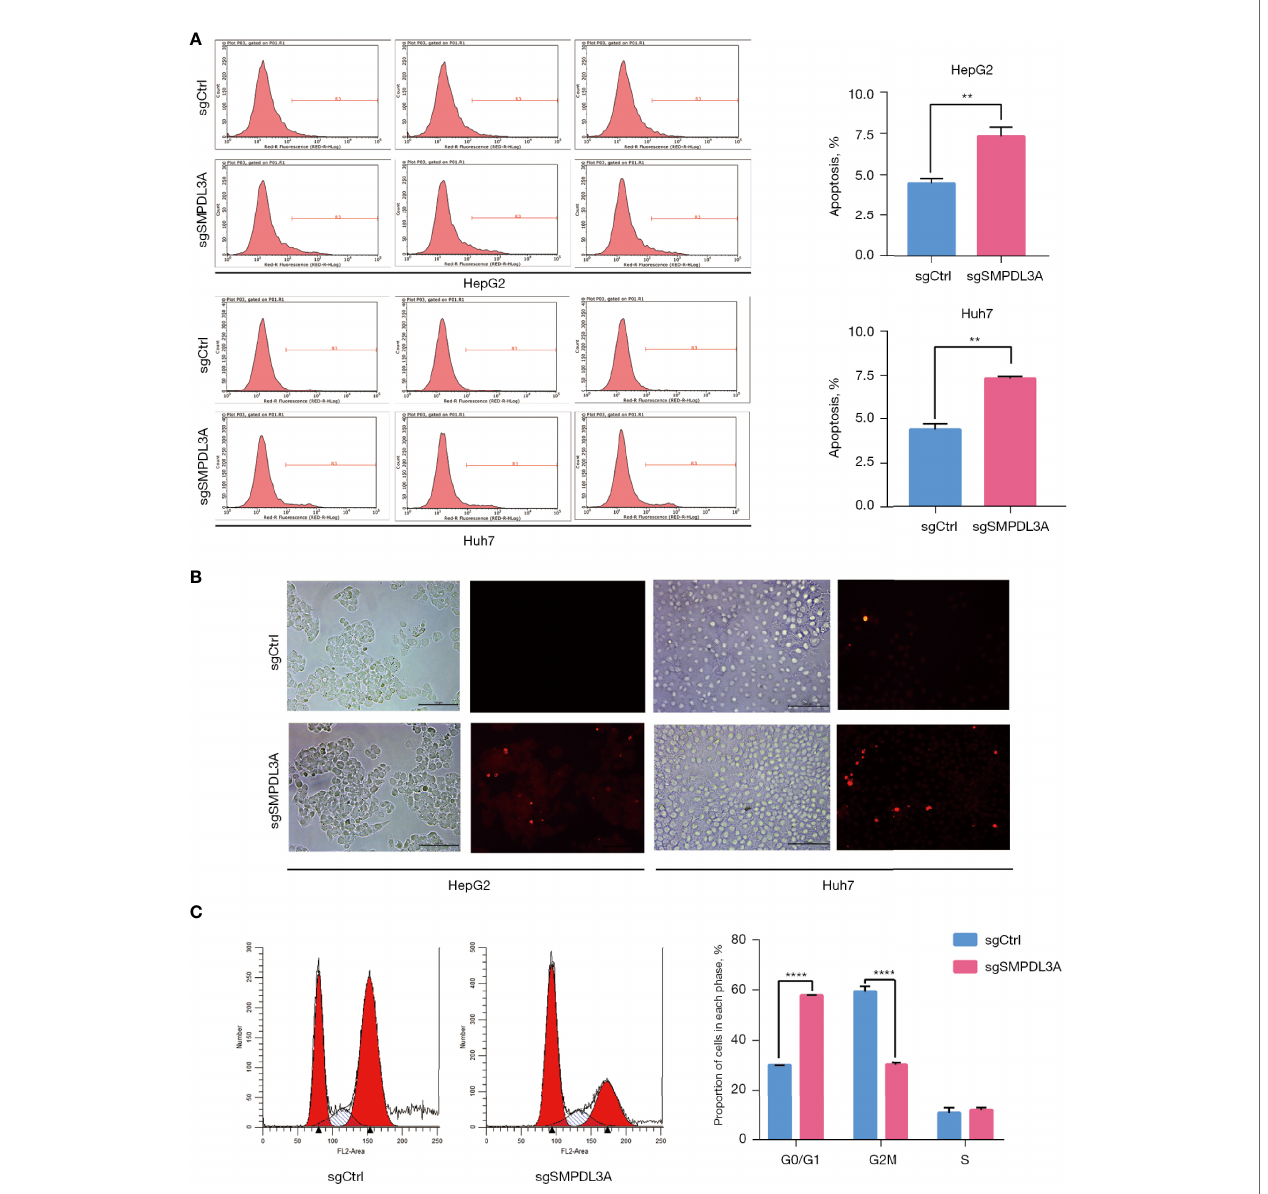
FIGURE 6 | The effect of SMPDL3A on the cycle and apoptosis. (A) Apoptotic cells were detected by fl ow cytometry (**P=0.01). (B) Fluorescence fi eld of HepG2 and Huh7 cells in the SMPDL3A knockout and control groups; apoptotic cells are marked by red fl uorescence. The proportion of apoptotic cells in the sgSMPDL3A group was signi fi cantly higher than that in the control group. (C) Cell cycle distribution was analyzed by fl ow cytometry the cells in the early DNA synthesis phage (G0 /G1) of the sgSMPDL3A group were signi fi cantly increased, while the cells in the late DNA synthesis phase (G2 phase) were signi fi cantly reduced